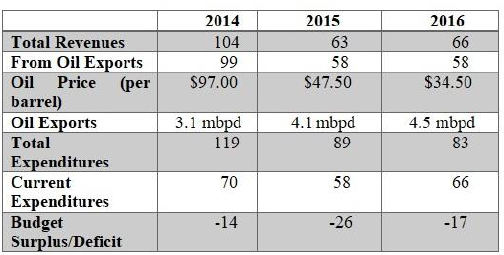
Source: Iraq’s Ministry of Oil (2016).